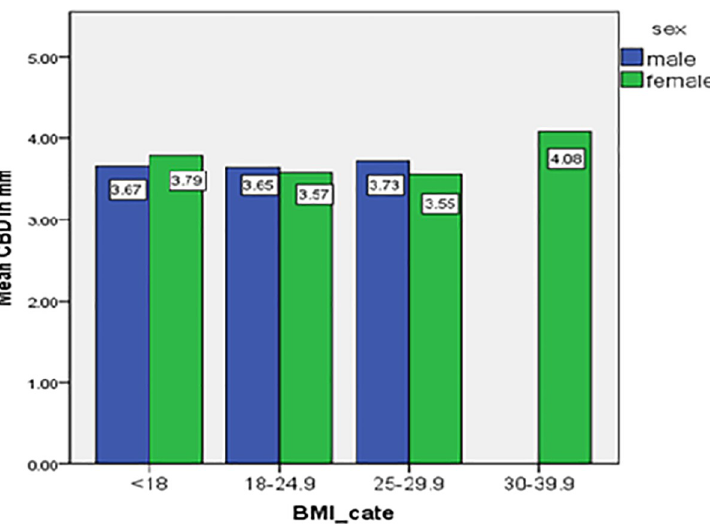
Fig 6. Bar graph showing the mean common bile duct diameter at different BMI categories.